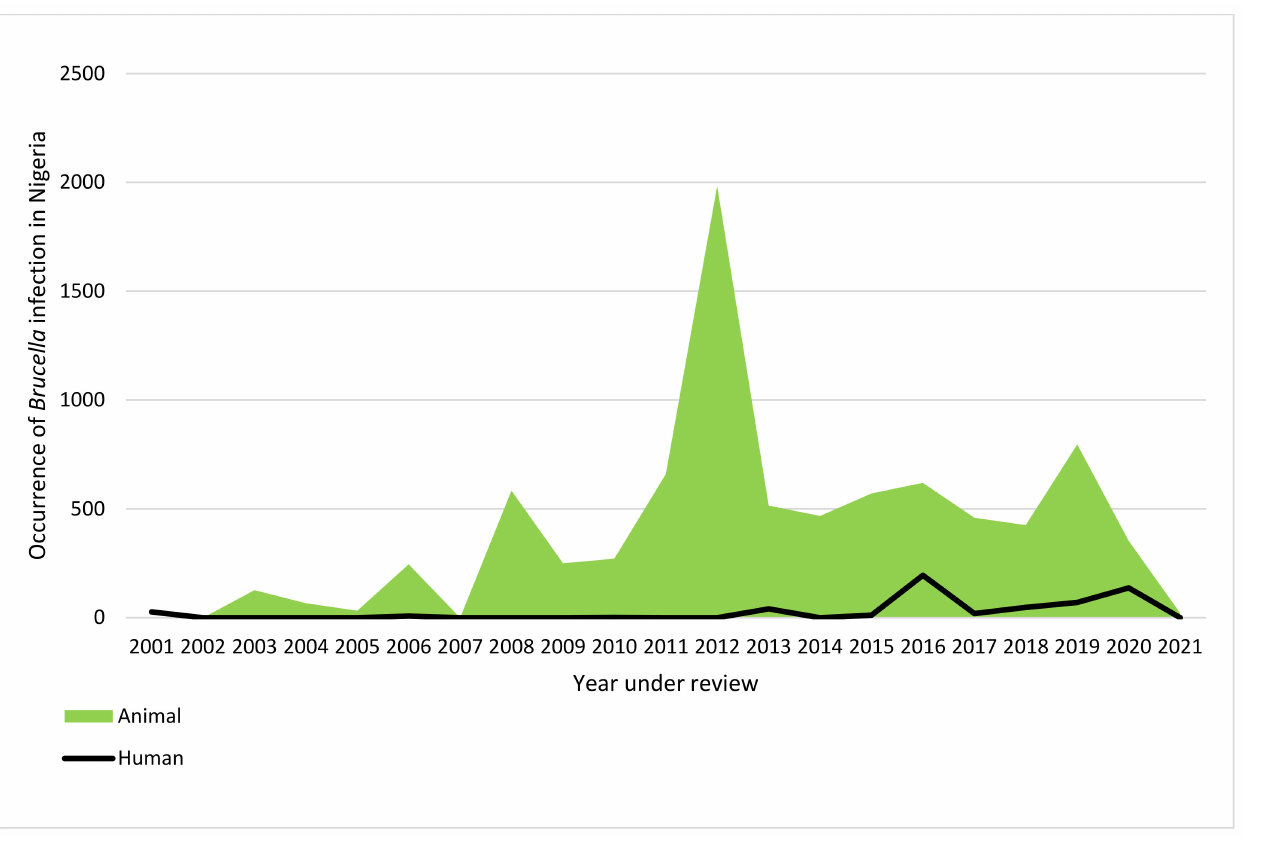
Figure 5. Trend of human and animal brucellosis in Nigeria from 2001 to